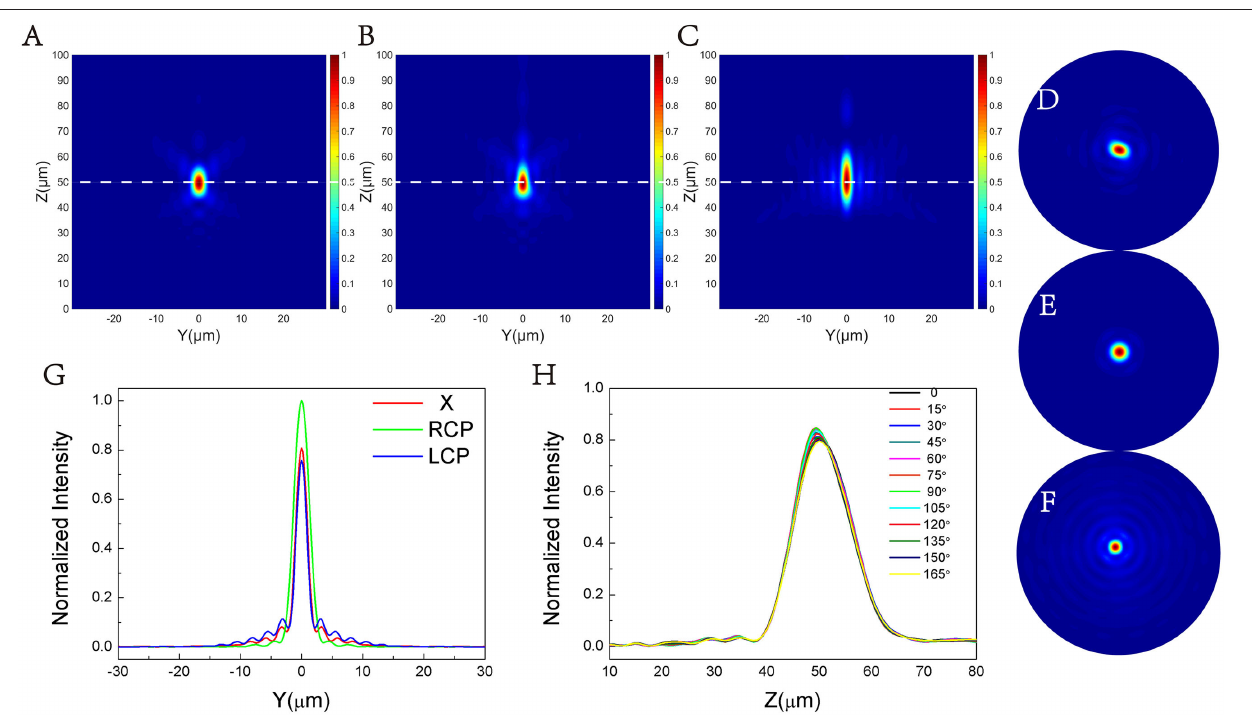
FIGURE 7 | Electric field intensity profile (y–z plane) for (A) LP incident light, (B) RCP incident light, (C) LCP incident light. (D–F) The electric field intensity diagram of the x–y plane, corresponding to the diagrams (A–C) . (G) The change of normalized electric field intensity with y in the three cases (z 2.31 µ m, 2.71 µ m, and 2.10 µ m, respectively. (H) The normalized distribution of electric field intensity on the propagation plane (x with different polarization